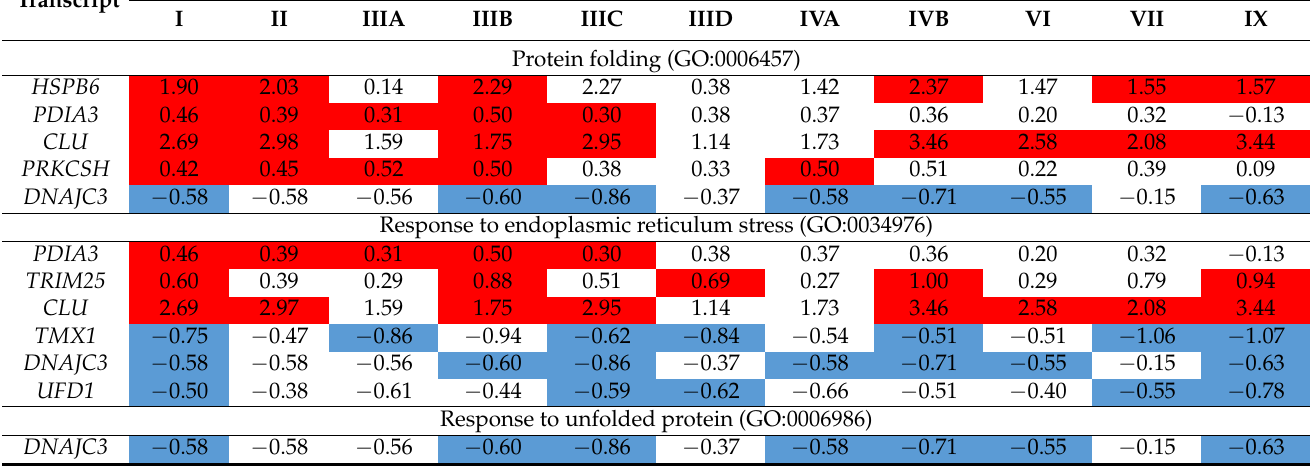
Table 3. Genes included into ‘protein folding’ (GO:0007165), ‘response to endoplasmic reticulum stress’ (GO:0034976), and ‘response to unfolded protein’ (GO:0006986) terms of Gene Ontology with expression significantly changed (at FDR < 0.1; p < 0.1 in one-way ANOVA and post hoc Student’s t -test with Bonferroni correction) in most (5 or more) MPS types relative to control cells (HDFa). Down-regulated and up-regulated genes are marked in blue and red, respectively. Non-marked values indicate results in which no statistically significant differences between MPS and HDFa were determined.